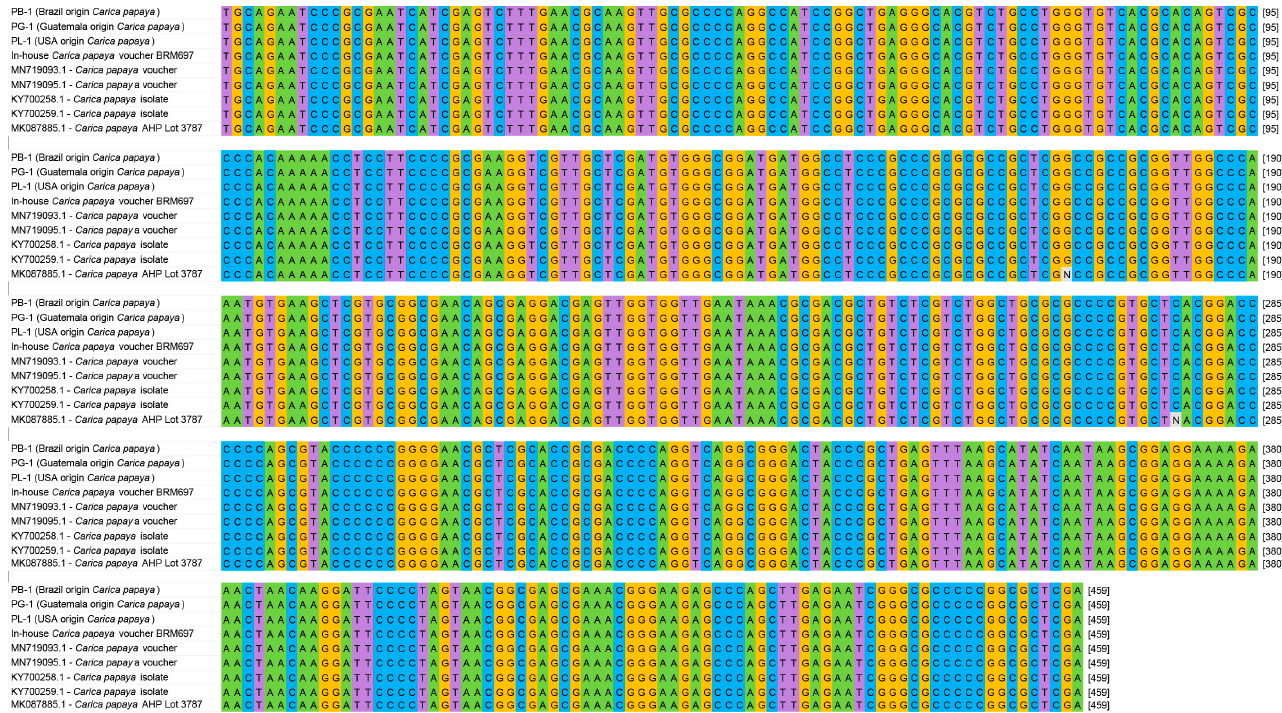
Figure 1. Alignment of ITS2 sequences from fresh fruit papaya samples used in this study to voucher and reference material sequences collected in-house and from public databases.